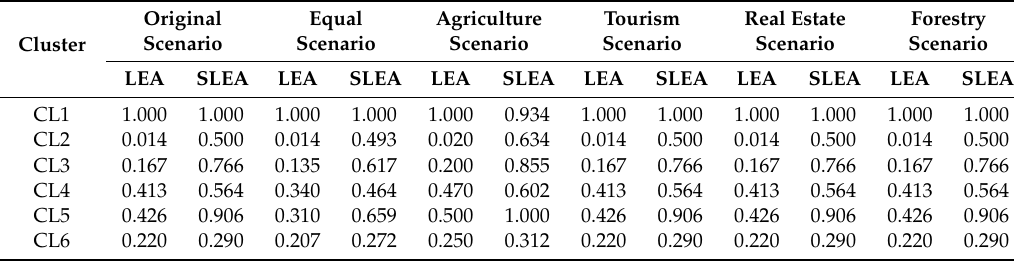
Figure 8. Results of sensitivity analysis for the six core zones of vineyard landscape for LEA (a) and SLEA (b) indices. Table 12. Results of sensitivity analysis for LEA and SLEA indices of the LRM landscape.